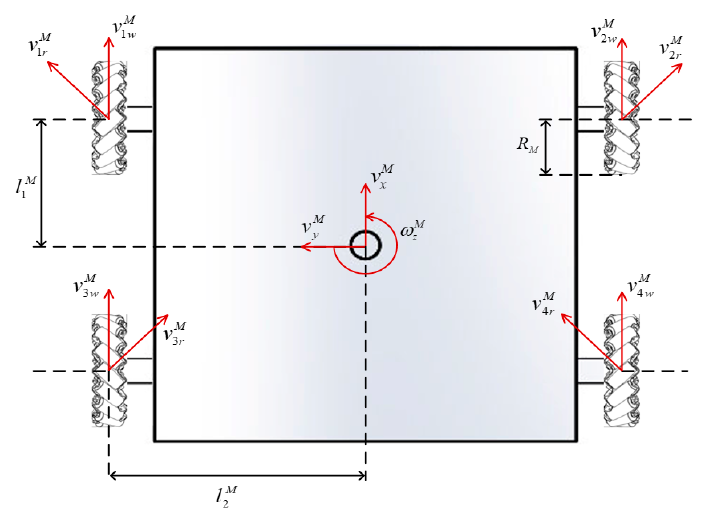
Figure 1. Geometrical structure of the Mecanum vehicles.